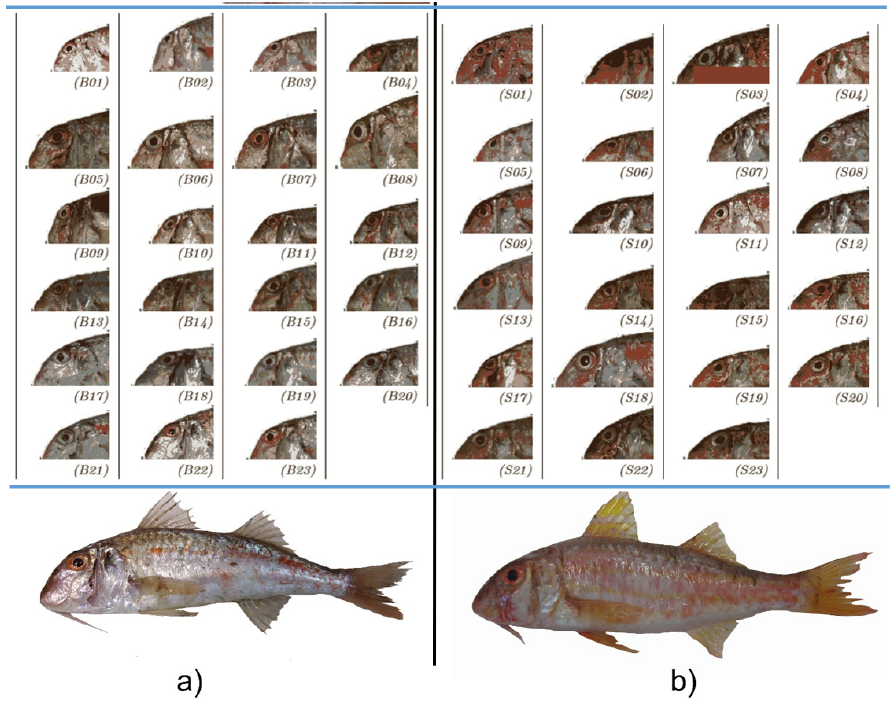
Figure 4. ( a ) Mullus barbatus and ( b ) Mullus surmuletus specimens in the database. The images on the top show the profile of interest according to taxonomist criteria. The specimens are identified with the letter B/S plus a